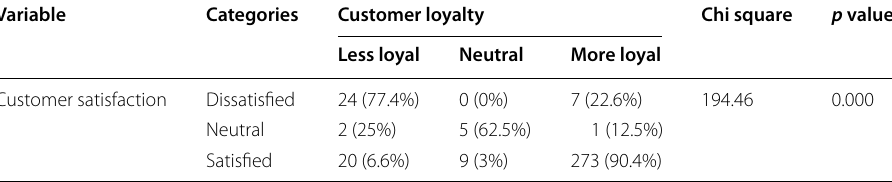
Source Own survey (2022)